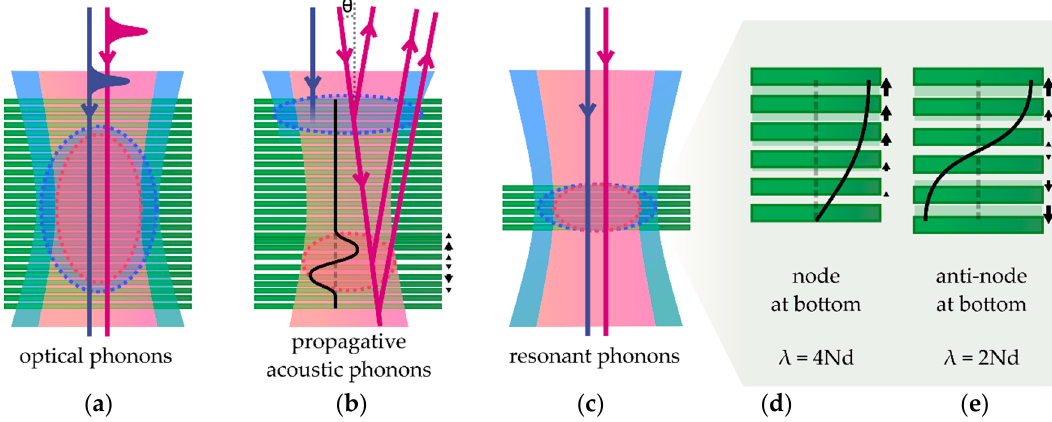
Figure 3. Schematic representations of the time-domain probing of coherent phonons of different nature in a layered material, namely ( a ) optical phonons, ( b ) propagative phonons, and ( c – e ) resonant phonons when the film is reduced to the nanoscale. Pump and probe pulsed beams are presented with blue and pink solid lines, respectively, as well as the respective pumped and probed regions with dashed circles in ( a – c ). Scattered beams at the top and bottom interfaces, and at the propagative strain wavefront with a resulting different optical paths are shown in ( b ). The spatial acoustic waveform is presented with a solid black line in ( b , d , e ) along with black arrows indicating the corresponding out-of-plane displacement.